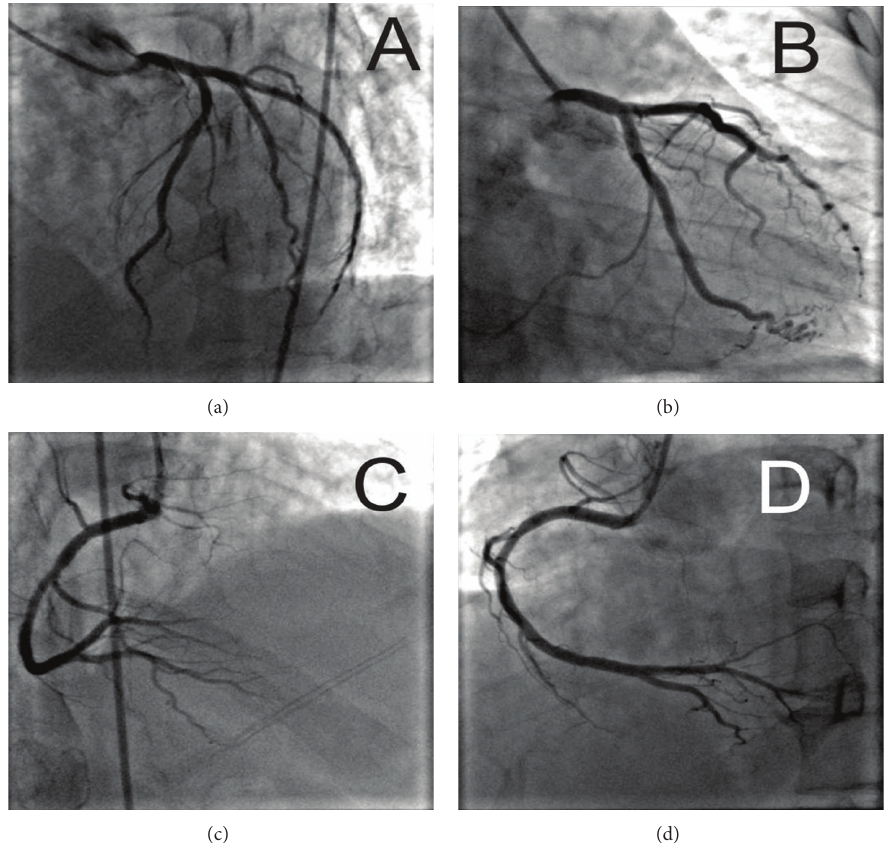
Figure 4: Conventional angiographic projections are shown to evaluate the left anterior descending artery, circumflex artery (cranial and oblique projections, (a) and (b), resp.), and right coronary artery (cranial and oblique, (c) and (d), resp.). No significant coronary disease was